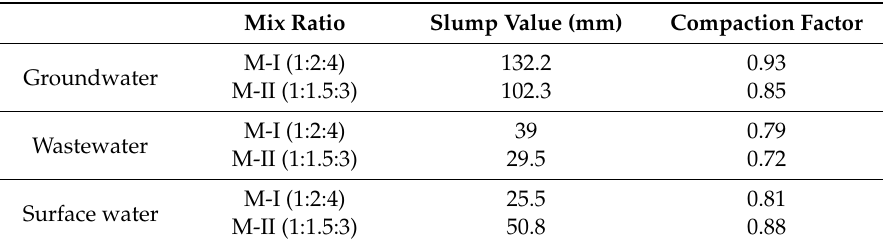
Table 2. Properties of fresh concrete developed with different water resources.